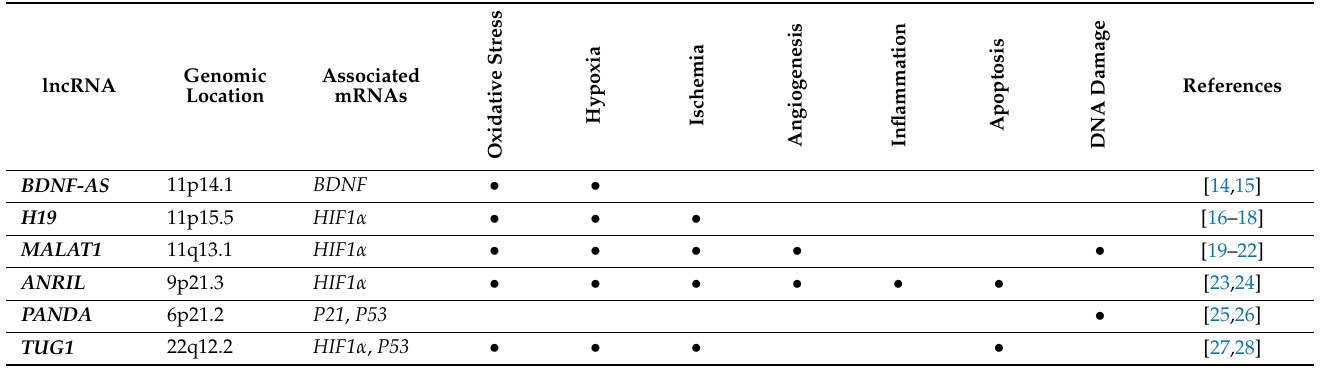
Table 1. Summary of selected lncRNAs associated with hypoxia and oxidative stress, or induced by other stress